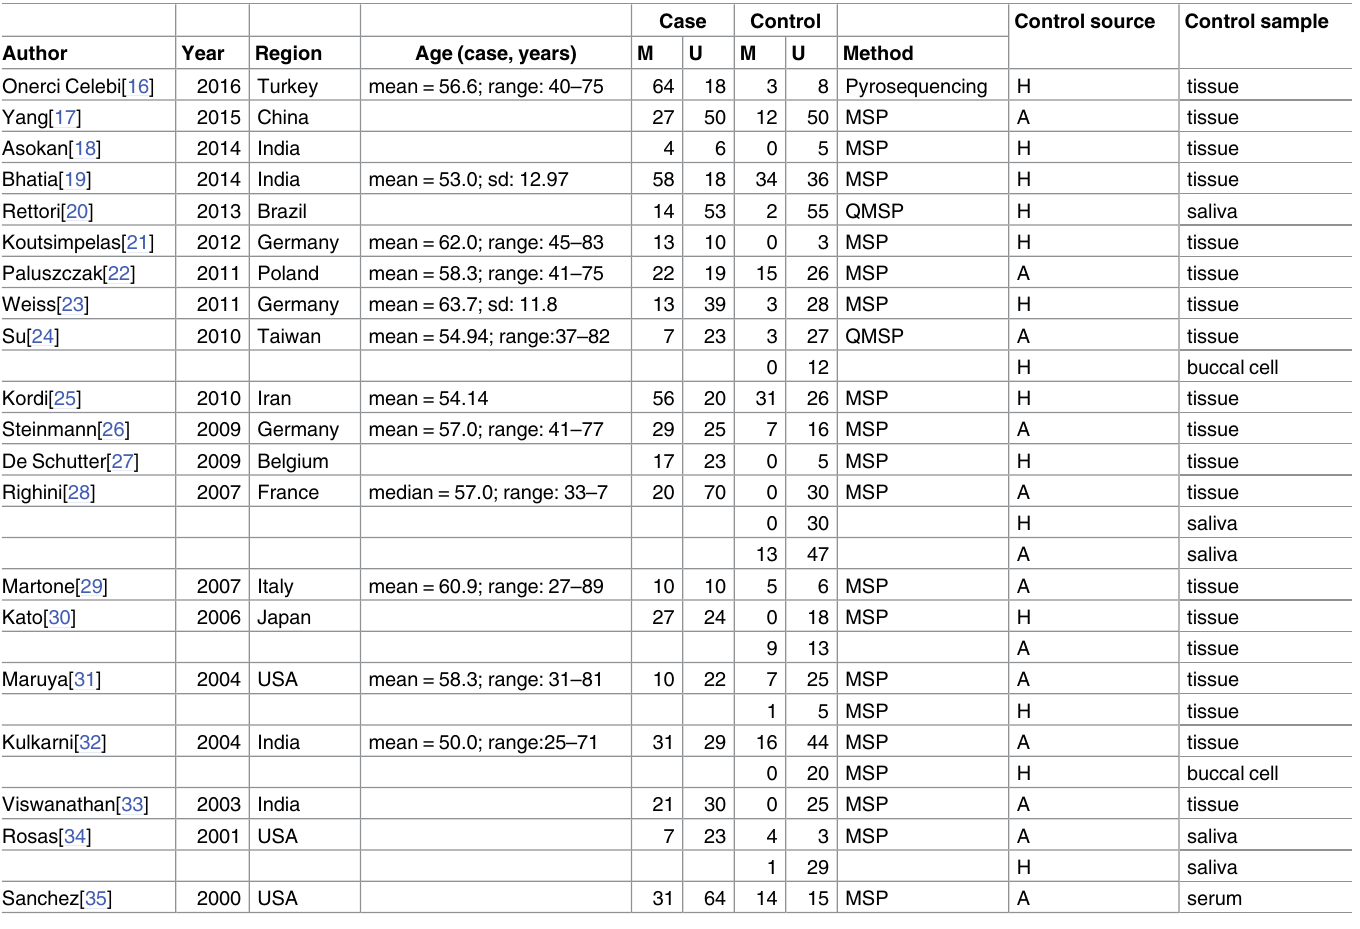
Table 1. Characteristics of studies included in the